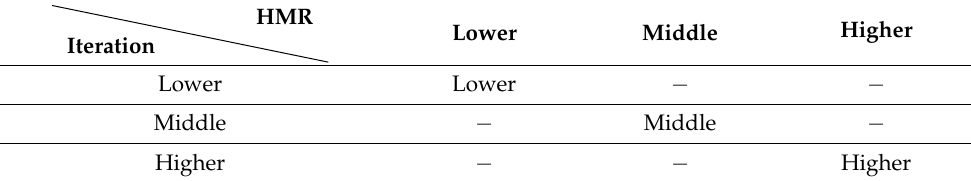
Table 2. Representation of fuzzy rules.